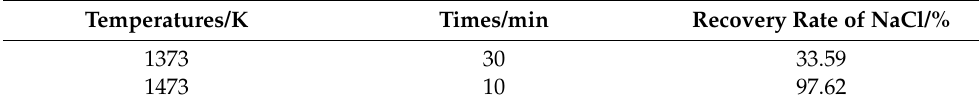
Table 4. Recovery rate of NaCl at different phase transformation temperatures and times. Temperatures/K Times/min Recovery Rate of NaCl/% 1373